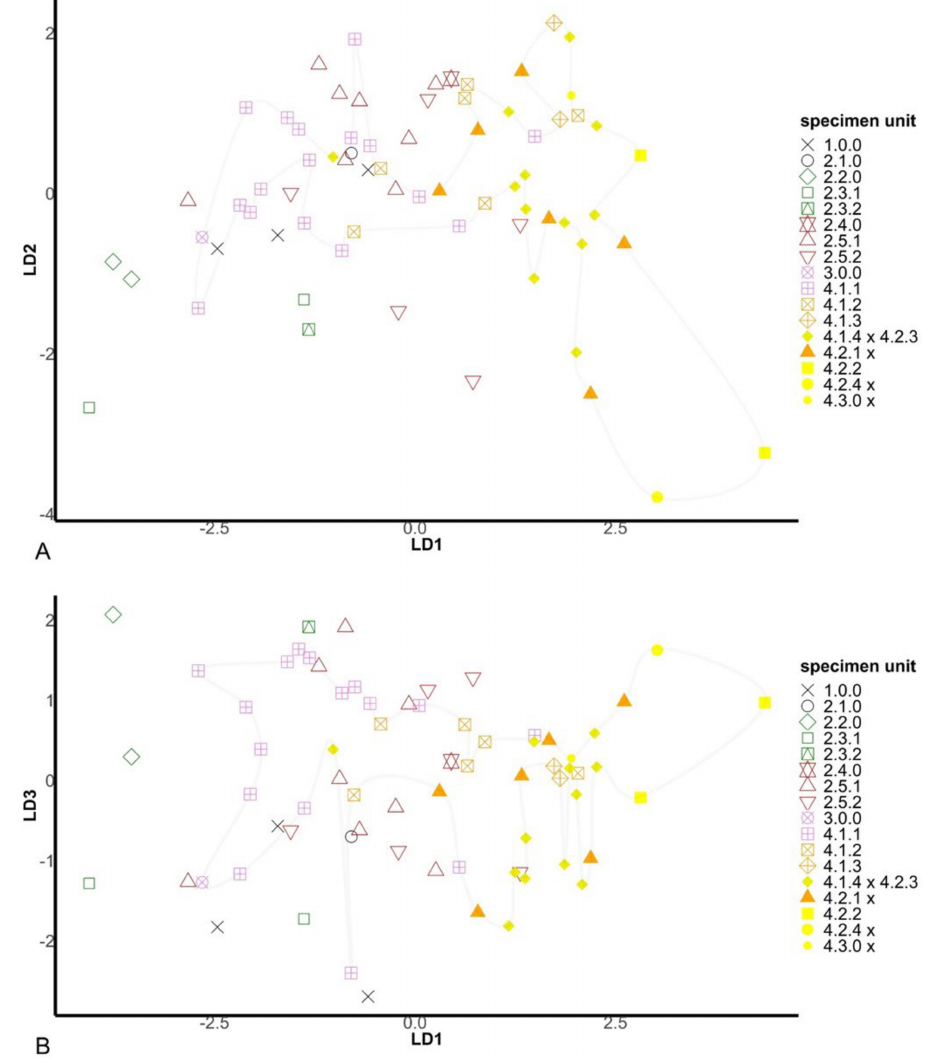
Figure 5. Discriminant analysis relating ITS-based genotype to specimen units. Symbols and colors according to genotypic specimen units (based on observed genotypes). Light grey polygons are manually drawn to indicate the outer perimeter of the Mentha longifolia s.s.– Mentha suaveolens complex, as a central core within the Mentha spicata s.s. complex (outer shell). ( A ) DA1–2. ( B )